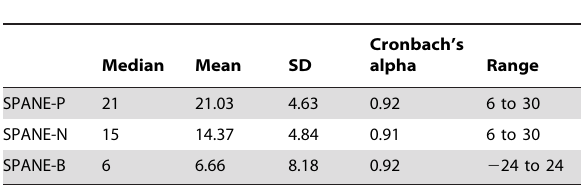
Table 6. Summary statistics for the SPANE ( N =21,322